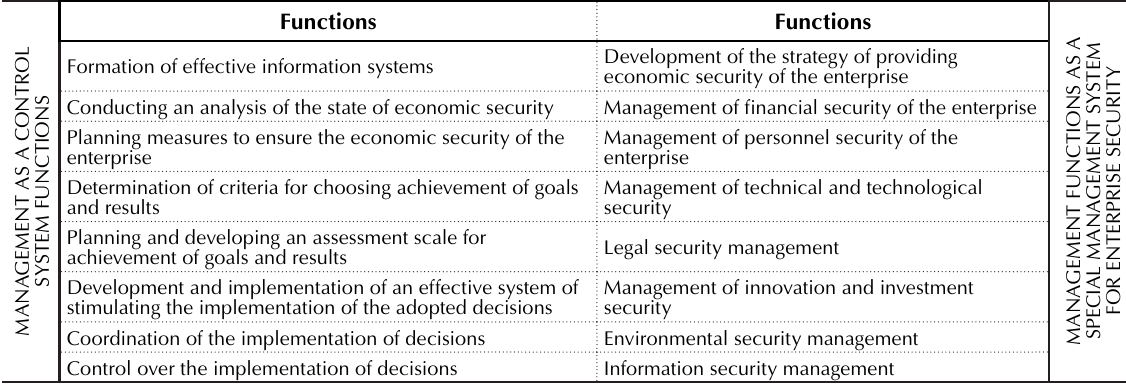
Table 1. Distribution of the main functions of enterprise economic security management